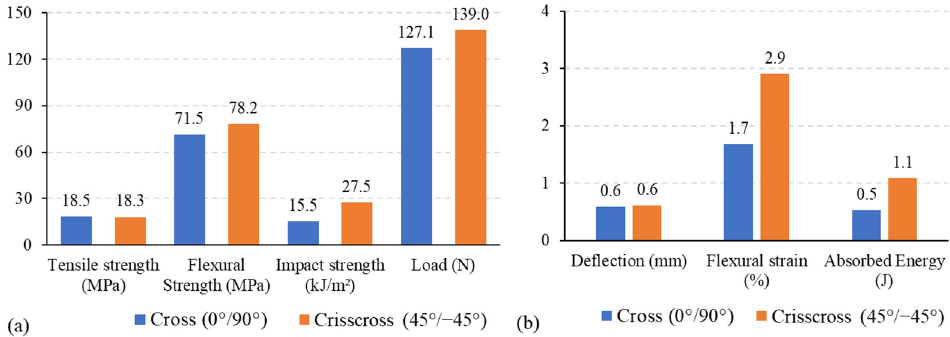
Figure 6. Effects of raster angle on different mechanical properties ( a ) and ( b ) of ABS.